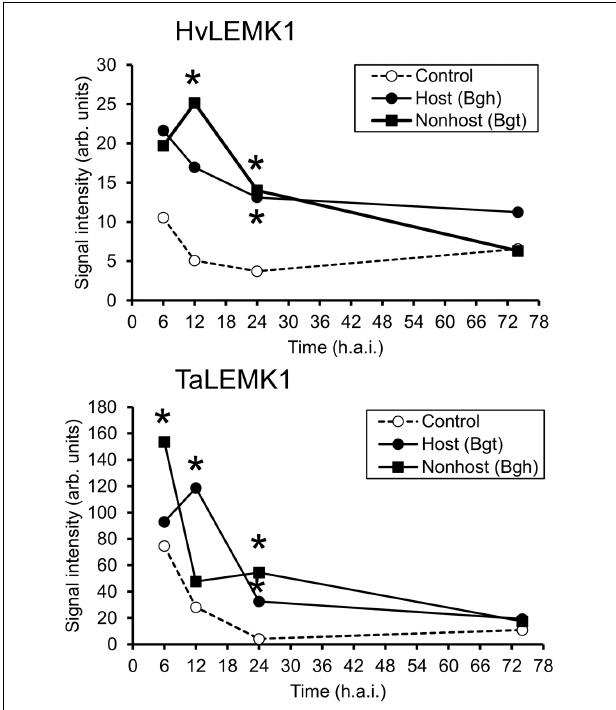
FIGURE 3 | Rapid transcriptional up-regulation of LEMK1 in wheat and barley epidermis following inoculation with adapted or non-adapted powdery mildew fungi. Data of three independent inoculation experiments were derived from Agilent 44K oligonucleotide microarrays, as described in section “Materials and Methods.” Asterisks indicate significant transcript regulation between inoculated and non-inoculated control plants (FDR-corrected p -value < 0.05). h.a.i., hours after